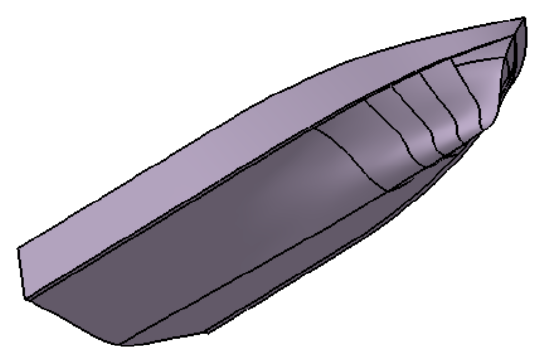
Table 1. Parameters of the model of USV01.